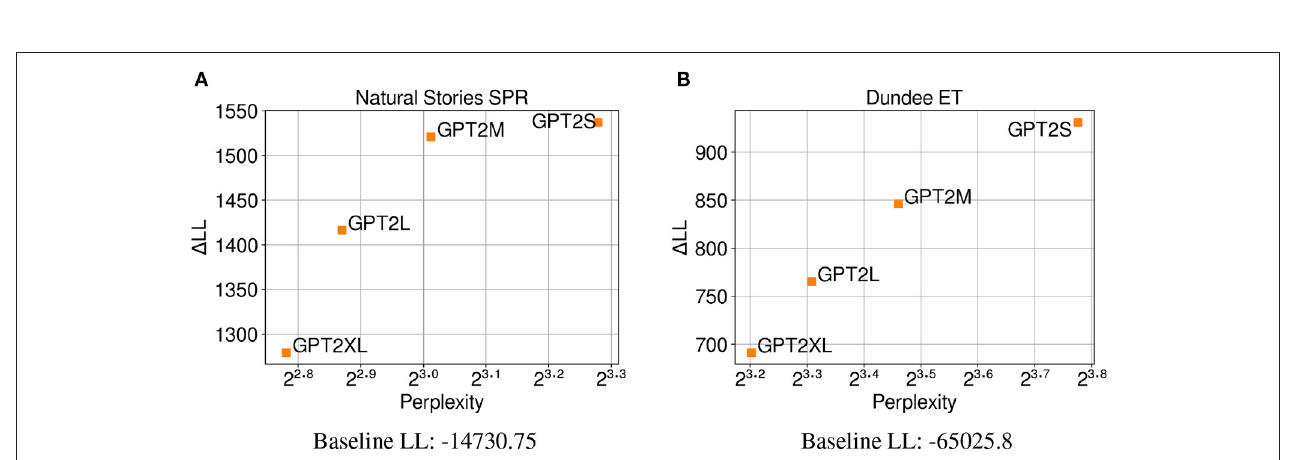
FIGURE 6 | Perplexity measures from each GPT-2 model, and improvements in CDR model log-likelihood from including each surprisal estimate on (A) Natural Stories self-paced reading data and (B) Dundee eye-tracking data. The difference in by-item squared error between the GPT2S and GPT2L models is significant at p < 0.05 level for the self-paced reading data, and the difference in by-item squared error between the GPT2S and GPT2M models is significant at p < 0.05 level for the eye-tracking